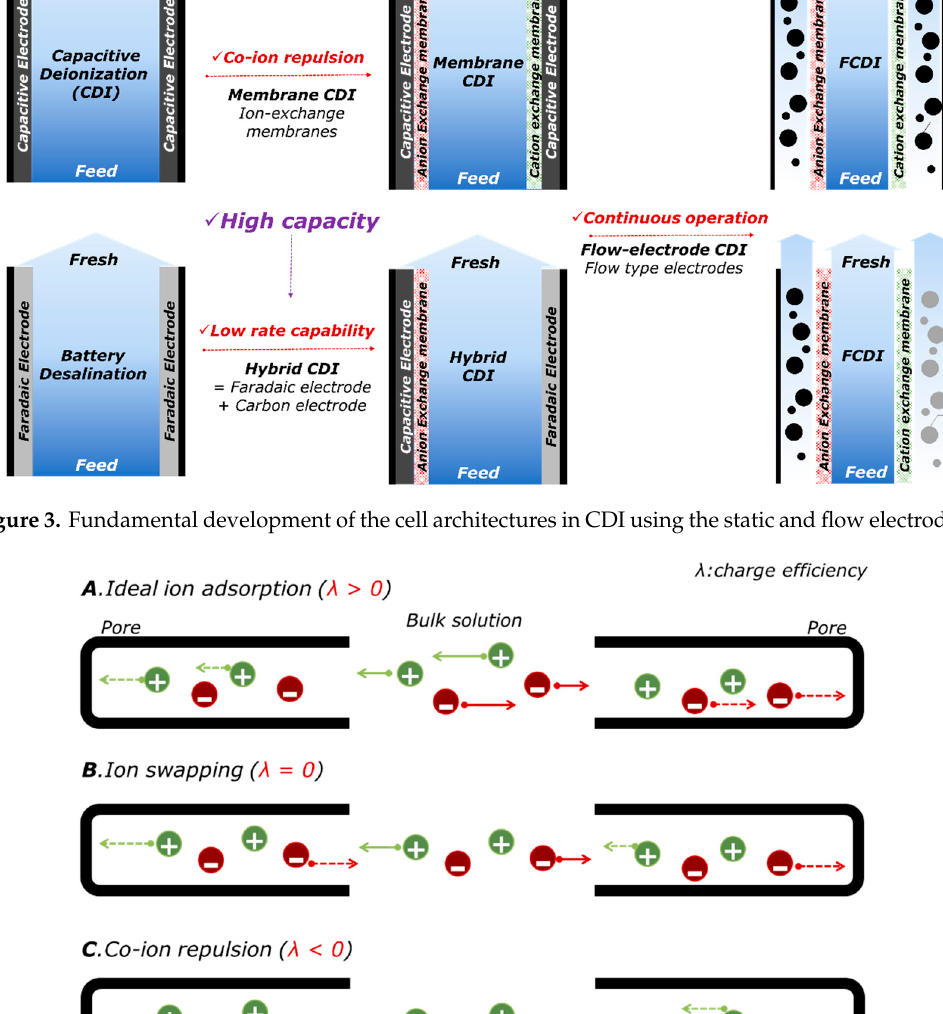
Figure 3. Fundamental development of the cell architectures in CDI using the static and flow electrodes.